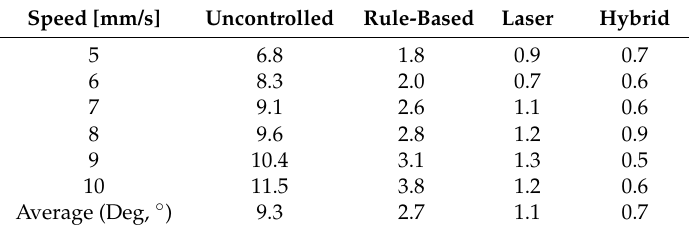
Table 1. Average head-tilting angles [deg].